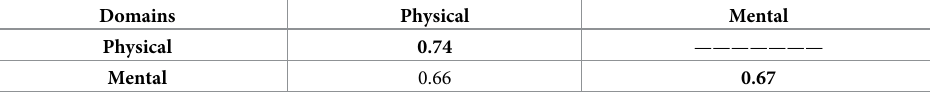
Table 5. Square roots of average variance extracted and correlations between the ASTA-Br-HRQOL domains. Domains Physical Mental Physical 0.74 ——————— Mental 0.66 0.67 Bold values: square root values of AVE. ASTA-Br HRQOL = the Arrhythmia-Specific Questionnaire in Tachycardia and Arrhythmia—Brazilian version- health-related quality of life